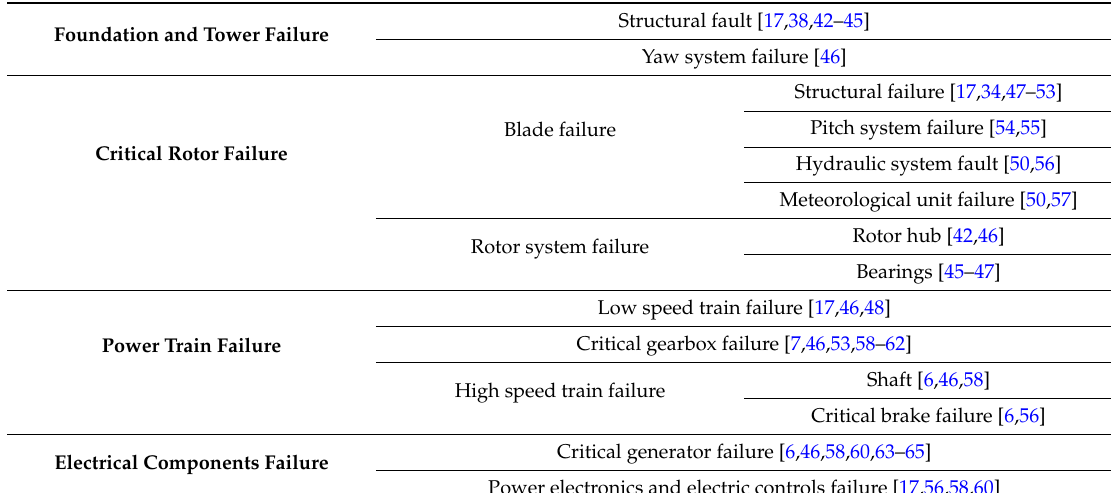
Table 1. Failures of the main elements of a